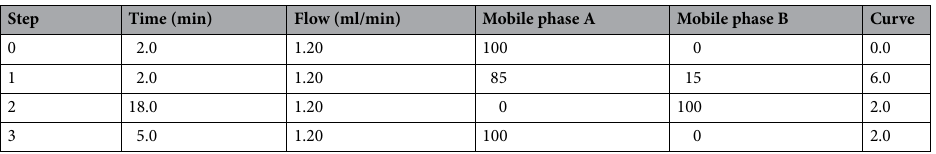
(min) of sample peaks with carboxyl porphyrin acid peaks (Supplementary Fig S1).